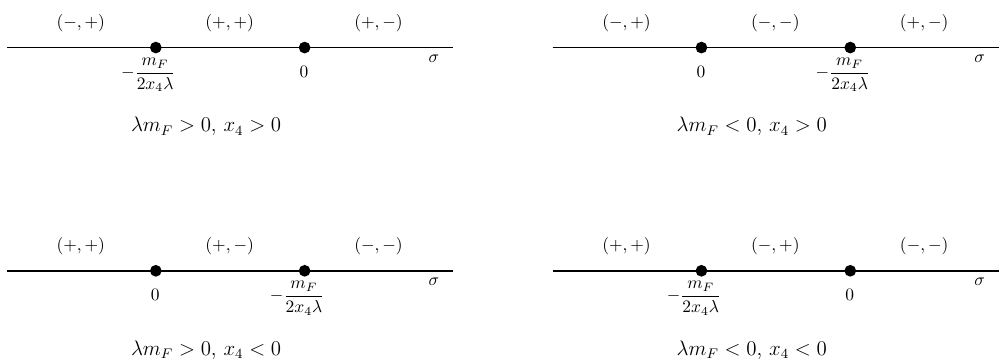
Figure 3. Regions of validity for di(cid:11)erent branches of the potential for various choices of sgn( m F (cid:21) ) and sgn( x 4